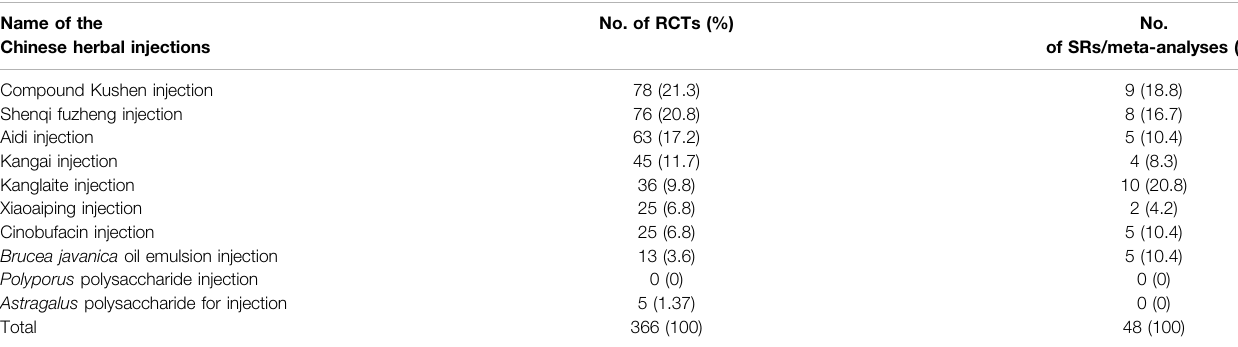
TABLE 2 | Number of included studies on ten Chinese herbal injections used in cancer care. Name of the Chinese herbal